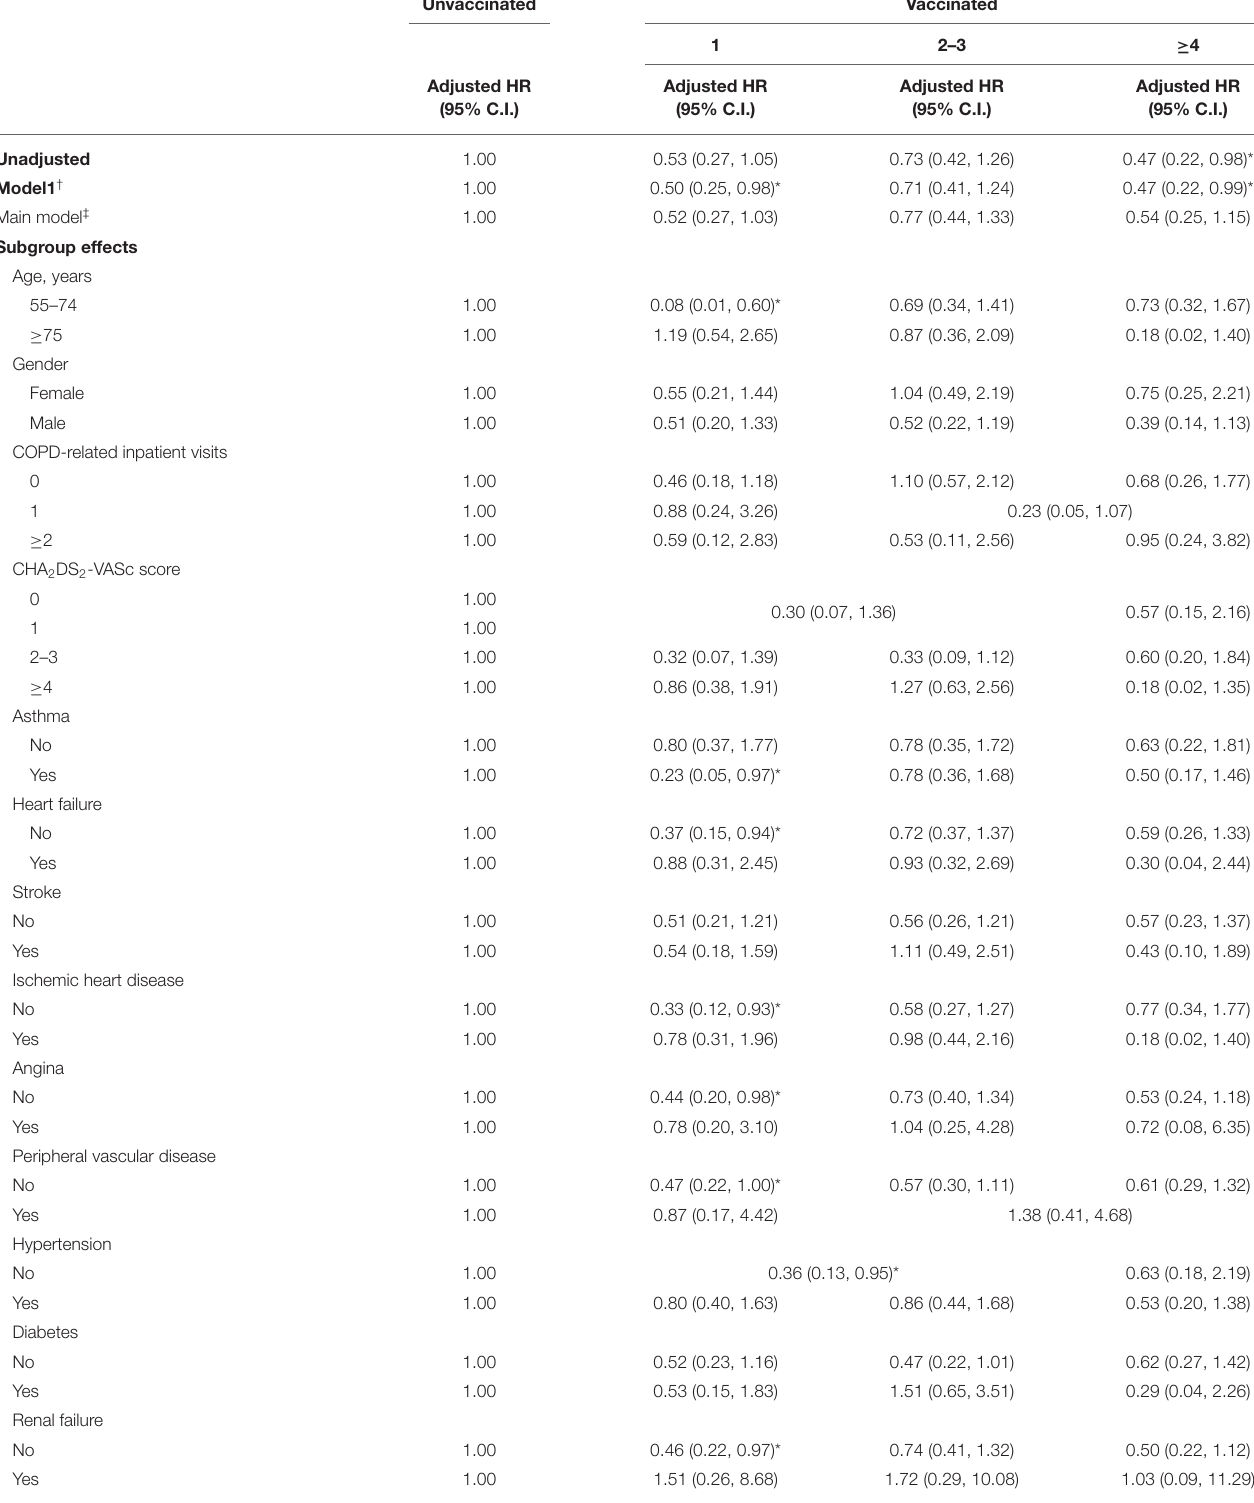
TABLE 3 | Sensitivity analysis of adjusted HRs of vaccination in risk reduction of ventricular arrhythmia in influenza